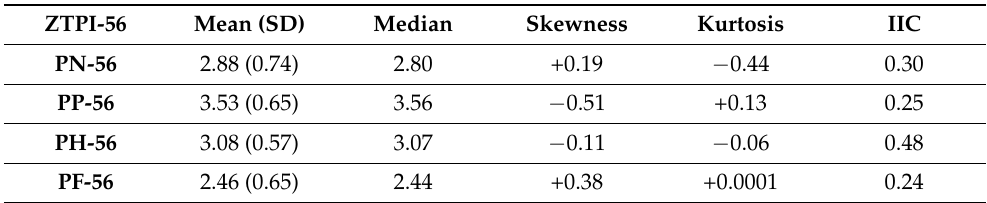
Table 1. The mean (and its SD), median, skewness, kurtosis, and mean inter-item correlations (IIC) for each subscale of the ZTPI-56 and ZTPI-16 are